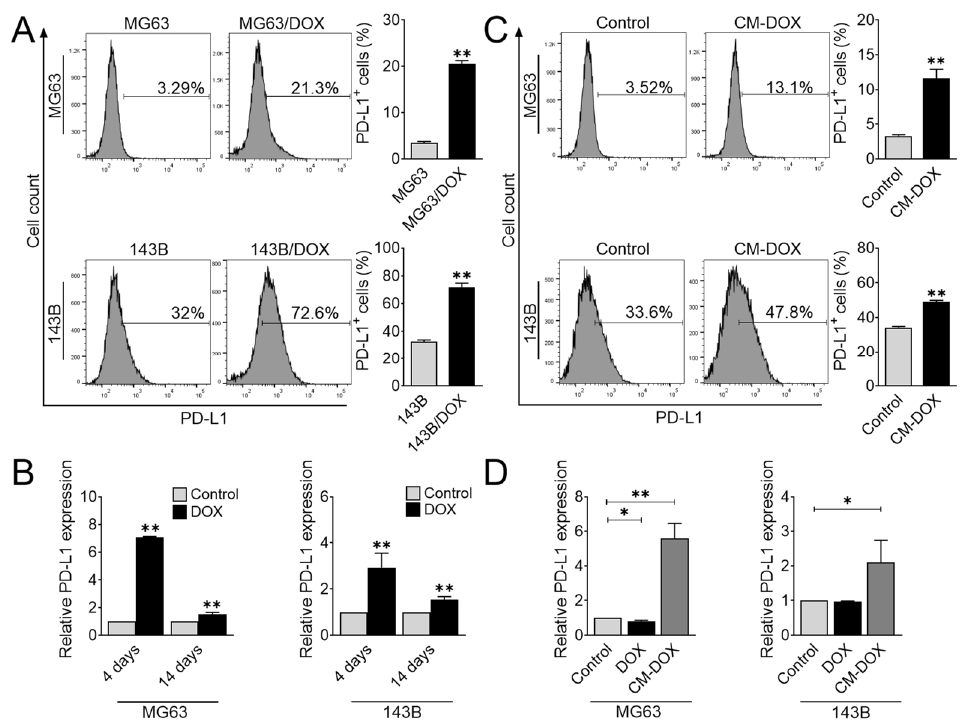
Figure 2. Doxorubicin accelerates PD-L1 expression in osteosarcoma cells. ( A ) Flow cytometric analysis of PD-L1 + osteosarcoma cells. MG63/DOX and 143B/DOX were analyzed for cell surface expression of PD-L1 using flow cytometry. The data represent the means ± SD. **, p < 0.01 vs. their parental cells. ( B ) PD-L1 gene expression in response to doxorubicin treatment. Osteosarcoma cells were treated with doxorubicin (40 nM) for 4 days, washed, and further cultured for an additional 10 days. The qRT-PCR was performed to evaluate PD-L1 gene expression on days 4 and 14. The data represent the means ± SD. **, p < 0.01 vs. control (0.04% DMSO). ( C ) Flow cytometric analysis of PD-L1 + osteosarcoma cells. MG63 and 143B cells were treated with CM-DOX for 48 h and then were analyzed for PD-L1 protein expression using flow cytometry. The data represent the means ± SD. **, p < 0.01 vs. control. ( D ) PD-L1 gene expression after CM-DOX treatment. Osteosarcoma cells were treated with CM-DOX or doxorubicin (40 nM) for 24 h, and qRT-PCR was performed to determine PD-L1 gene expression. The data represent the means ± SD. *, p < 0.05 and **, p < 0.01 vs. control (0.04% DMSO).